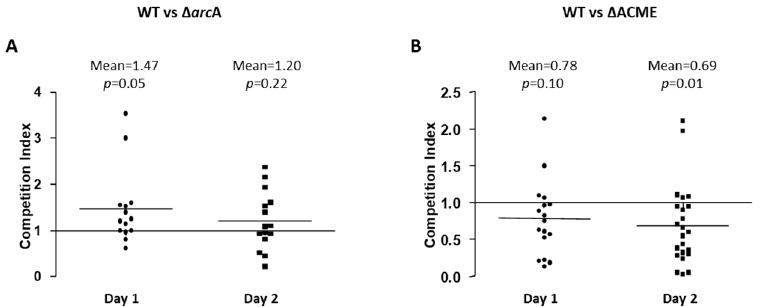
Figure 4. Survival of strain 2406 WT, ∆ arc A and ∆ ACME on the surface of plastic. WT vs. ∆ arc A ( A ) and WT vs. ∆ ACME ( B ) strains were mixed in equal proportions and survival competition experiments on plastic surface done. CIs of WT vs. ∆ arc A and WT vs. ∆ ACME indicated that ACME may not play a role in the bacterial survival on the plastic surface, with ∆ ACME showing lower death rates than WT. Student t tests were performed to determine significant differences between the CI and the value 1.